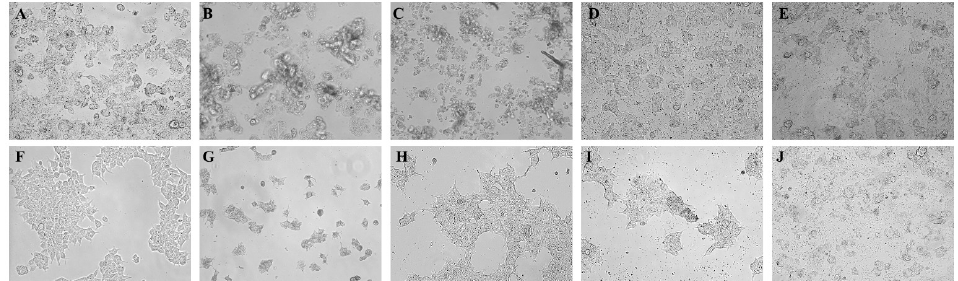
Figure 5. Effect of single pure substances on HepG2 and HEK293 cells morphology. The photographs were taken at a magnification × 40. Images are representative of three independent experiments. Where